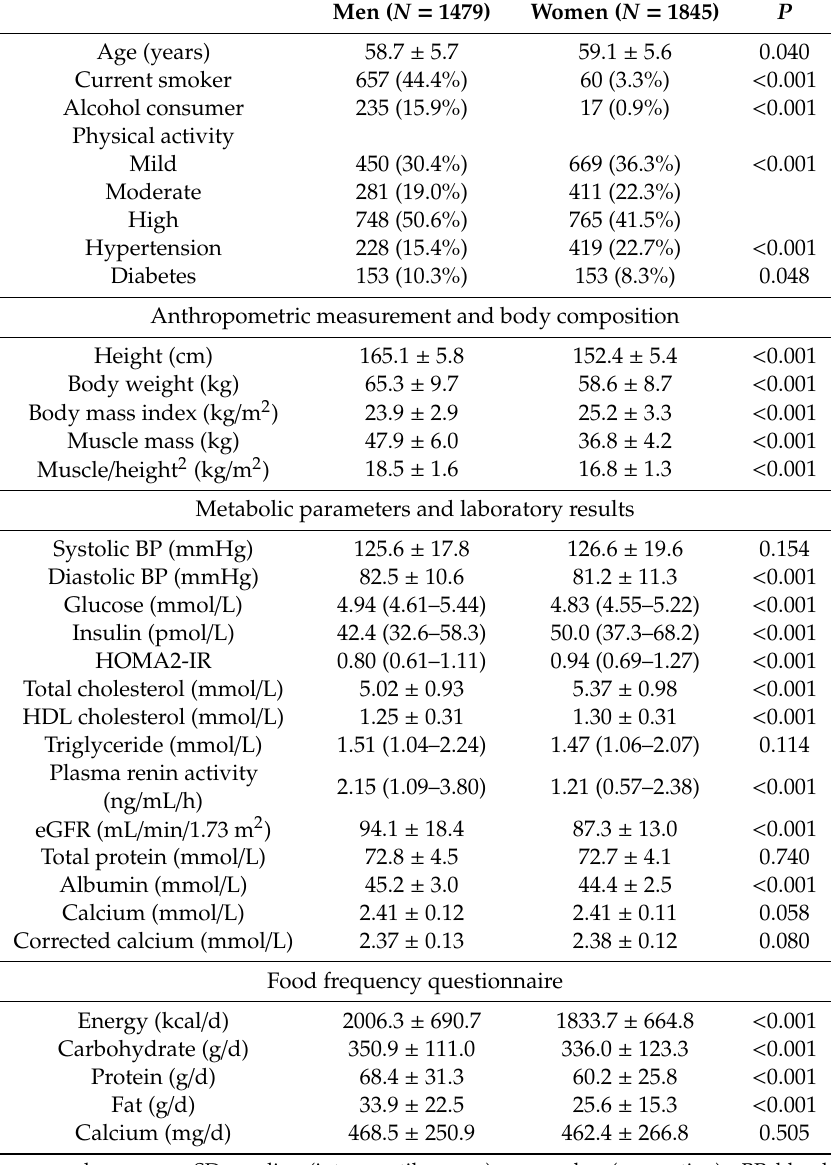
Table 1. Baseline characteristics of the study